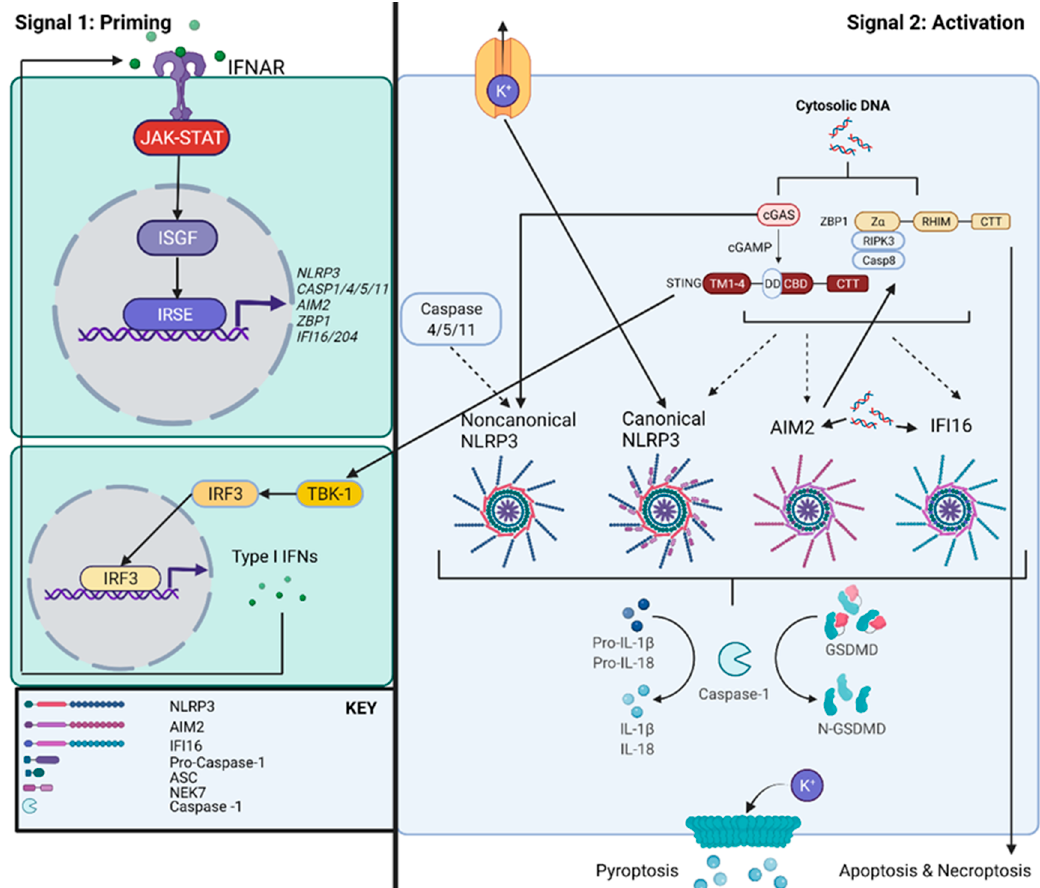
Figure 1. Mechanism of DNA effectors STING, ZBP1, and inflammasome activation in response to DNA. Inflammasome initiation of inflammatory cytokine activation and pyroptosis following nucleic acid stimulation can occur directly in the ALR inflammasomes AIM2 and IFI16. However, inflammasome activation to DNA, particularly by the NLR inflammasome NLRP3, may also be regulated by caspase-11/4/5 activation or the DNA sensing effectors STING and ZBP1. Upon sensing of DNA, effector STING in the cGAS axis induces the production of Type I IFNs, initiating IFN- alpha/beta receptor (IFNAR) and JAK-STAT activation of Interferon-stimulated Response Elements (IRSEs). This, in turn, promotes priming of inflammasome components and DNA effectors. The DNA sensing effector ZBP1 also initiates inflammasome activation and multiple forms of cell death in the proposed PAN-optosome pathway of cell death [3–12]. Created with BioRender.com (Agreement #AG23XLKR9E; accessed on 16 May